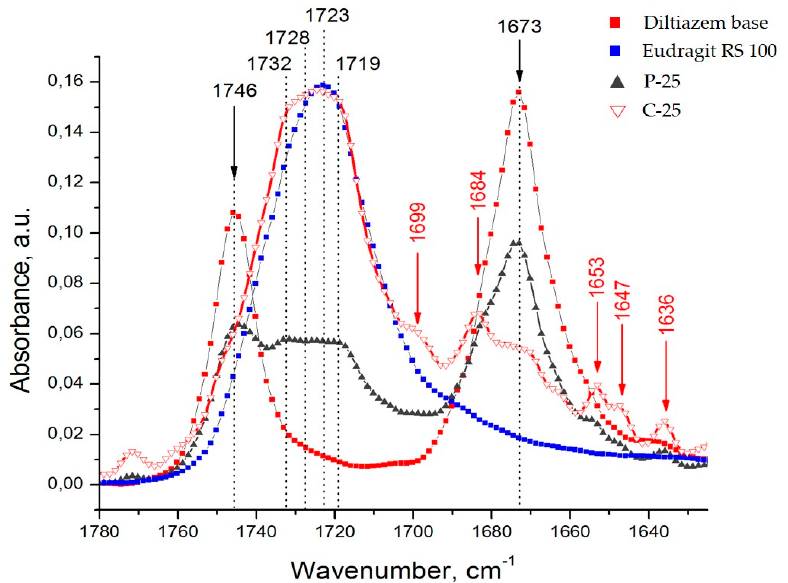
Figure 3. A sensitive region in the infrared spectra of diltiazem, Eudragit RS, and their control formulations—physical mixtures (P) and solid dispersions (C)—at 25% drug concentration (samples P-25 and C-25) .